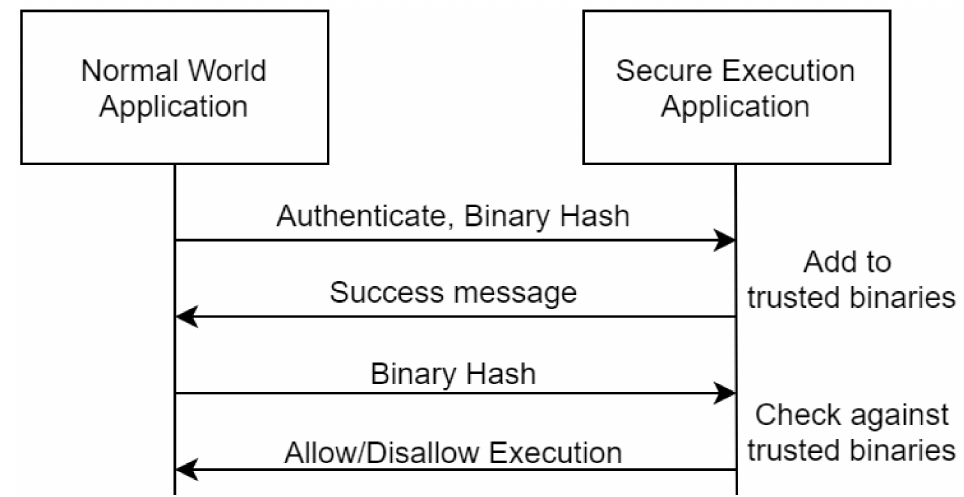
Figure 7. Overview of the secure execution